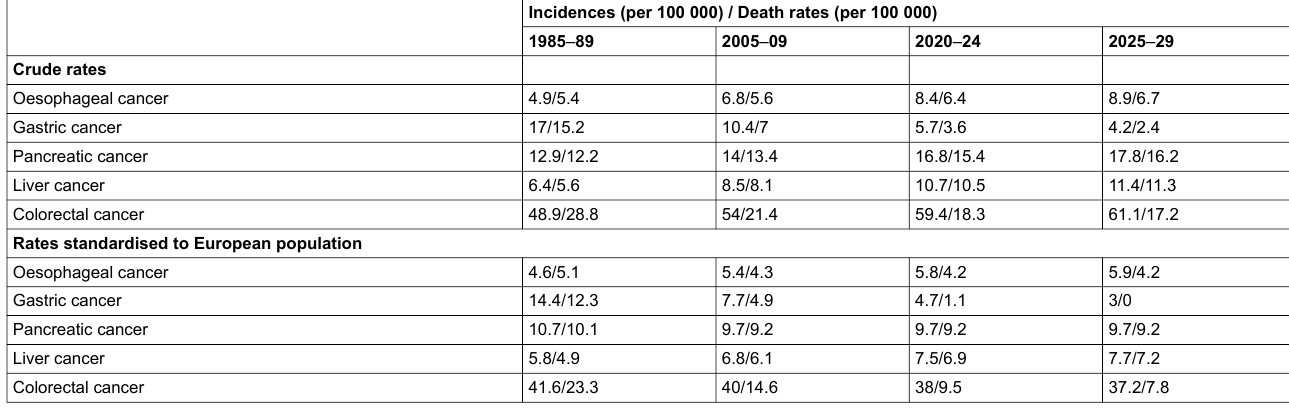
Table 1: Joinpoint predicted incidence and death rates (median per year per 100’000 inhabitants) in Switzerland compared to 1985–89 and 2005–09 for all five tumour entities.